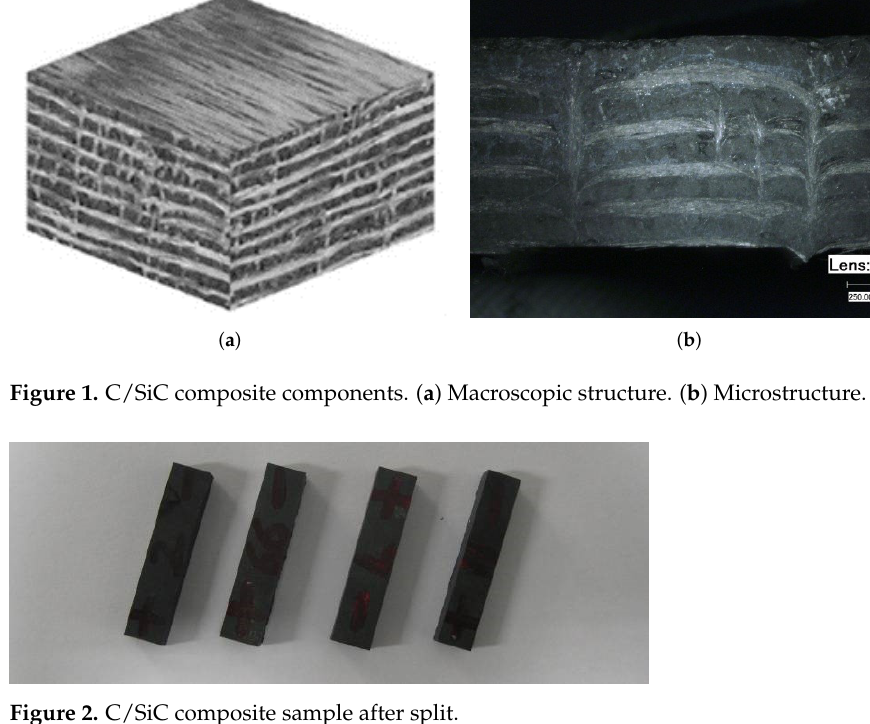
Figure 2. C/SiC composite sample after split.